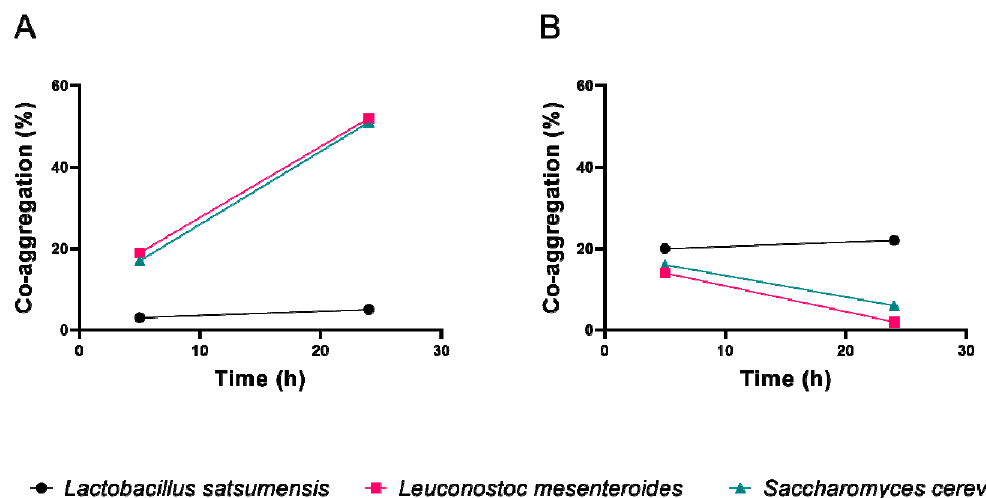
Figure 4. Co-aggregation of Lactobacillus satsumensis LPBF1, Leuconostoc mesenteroides LPBF2 and Saccharomyes cerevisiae LPBF3 with Escherichia coli ( A ) and Staphylococcus aureus ( B ) in 5 and 24 h.